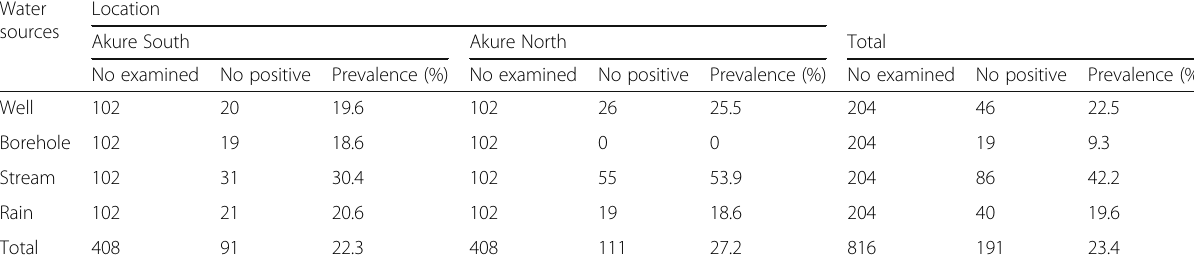
Table 1 Prevalence of parasitic contamination in water sources in the study areas Water sources